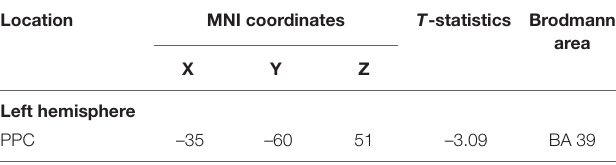
TABLE 3 | Maxima of regions showing significant differences between the Updating and control locations in the source space during the component P2N2 of the